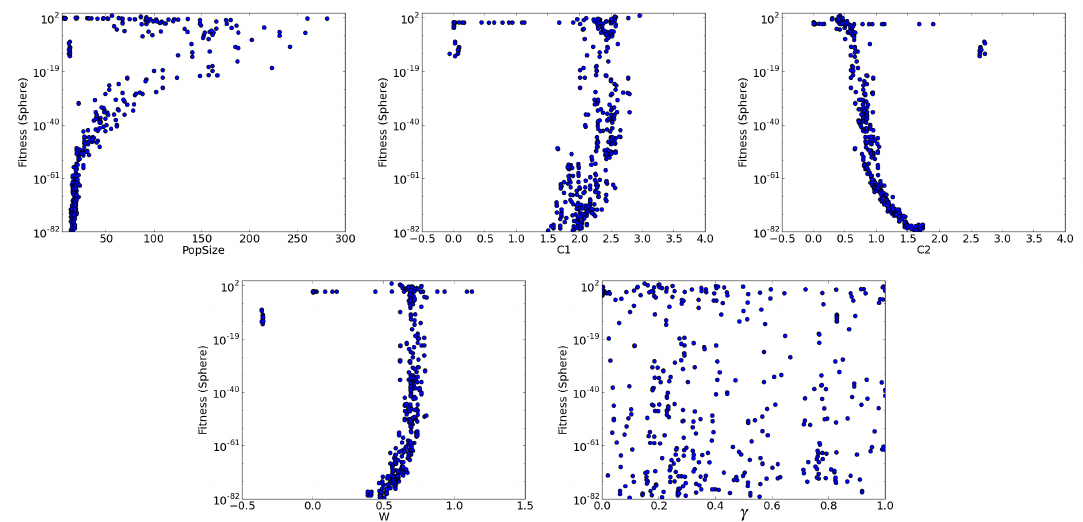
Figure A2. Values of fitness (Sphere function) versus PSO parameters at the end of the tuning procedure. The last graph refers to the useless parameter γ which, unlike the others, spans across all possible values with no correlation with fitness.